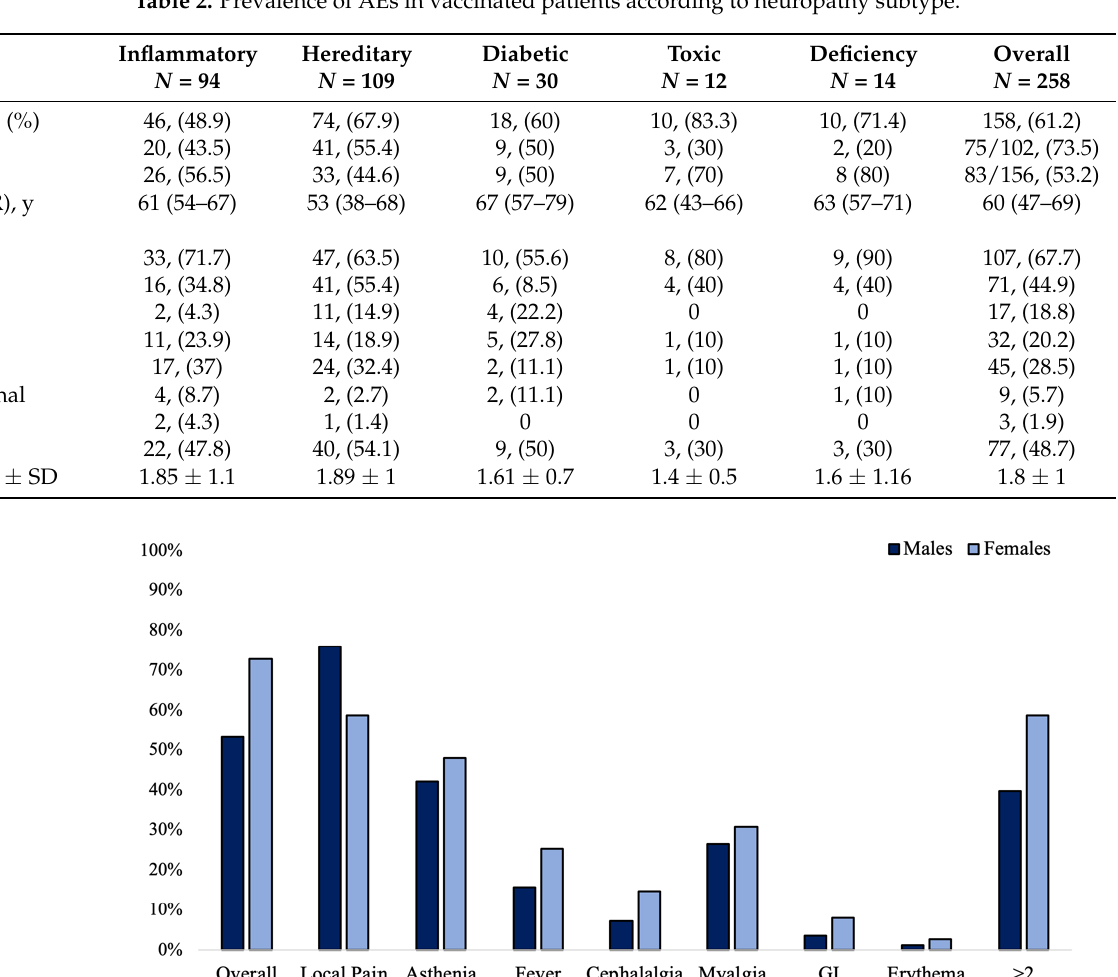
Figure 3. Prevalence of adverse events in n = 258 vaccinated patients depending on gender. The number of AEs was inversely correlated with age (Spearman, r= −0.15; p = 0.03).